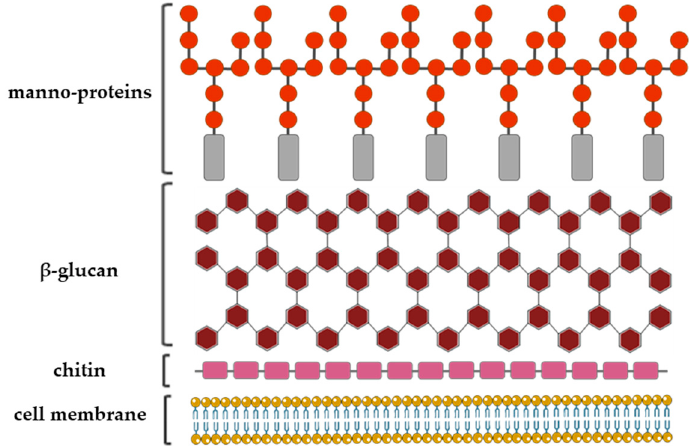
Figure 3. A schematic representation of the Aspergillus fumigatus cell wall structure with a depiction of the three major cell wall features, including chitin, glucan and galactomannan [14,23].